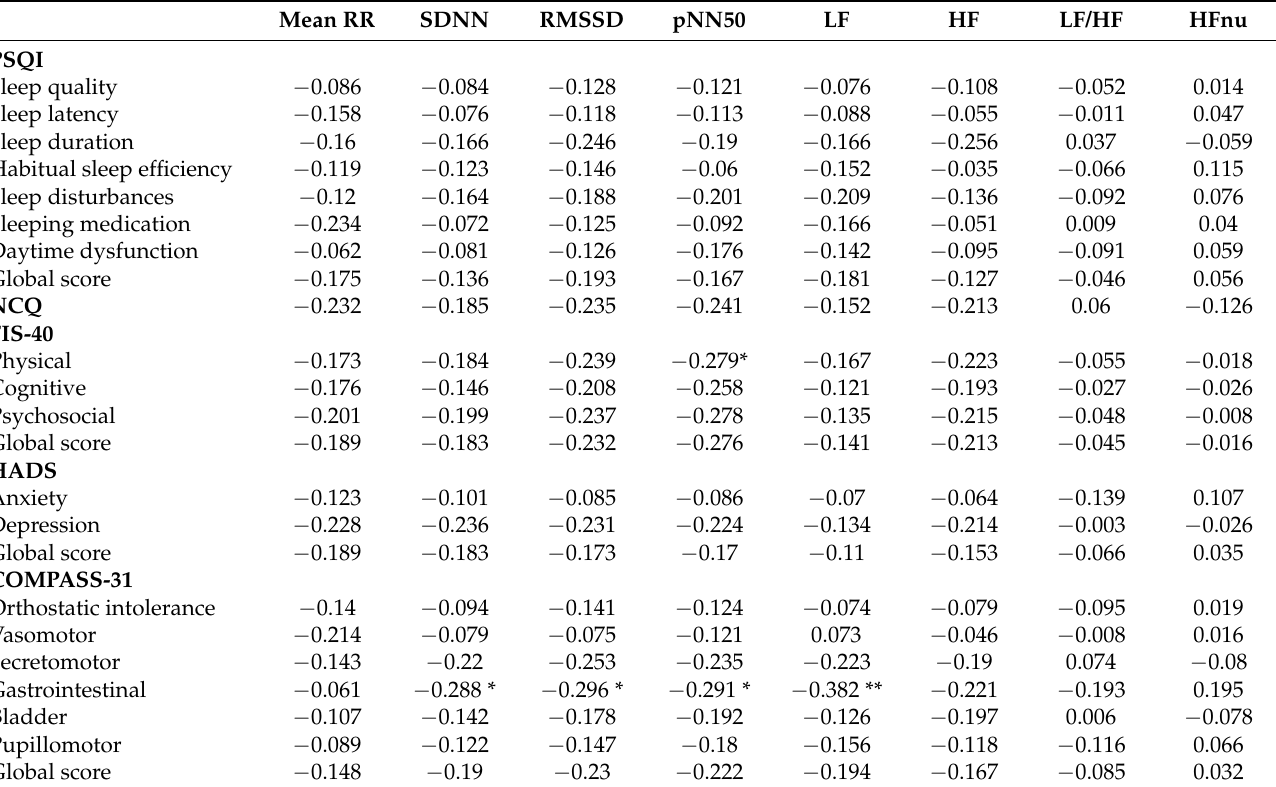
Table 3. Pearson correlation coefficients (r) between HRV parameters and self-reported measures ( n = 51